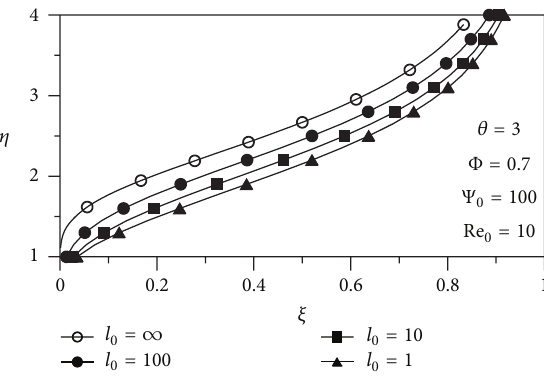
Figure 10: Effect of 𝑙 0 on optimum profile of metal